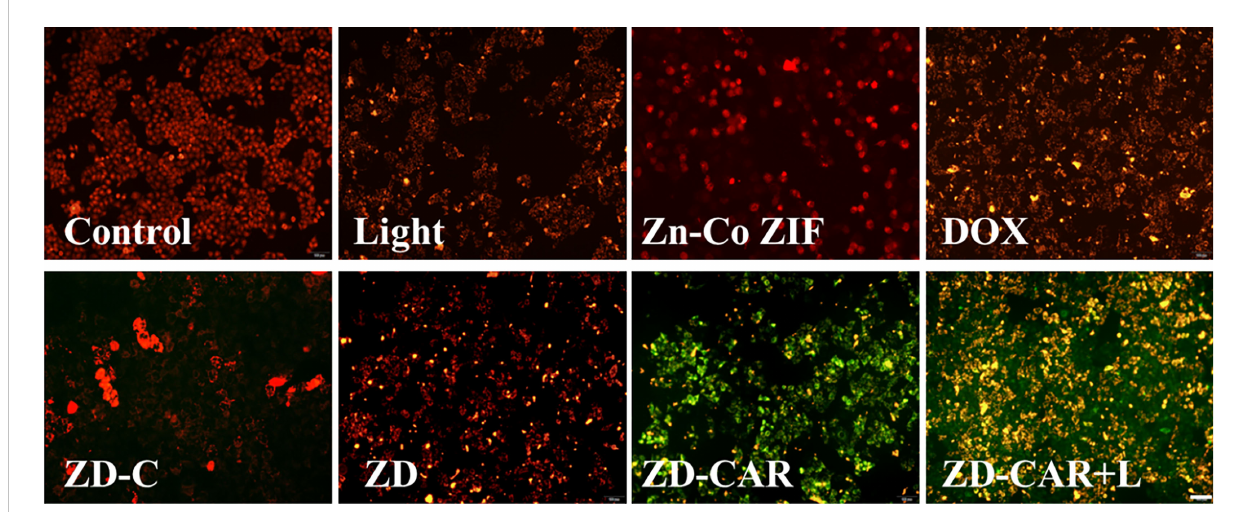
FIGURE 10 Jc-1 staining on HepG 2 cells treated with different materials (incubate for 24 hours). Scale bar is 100 m m.